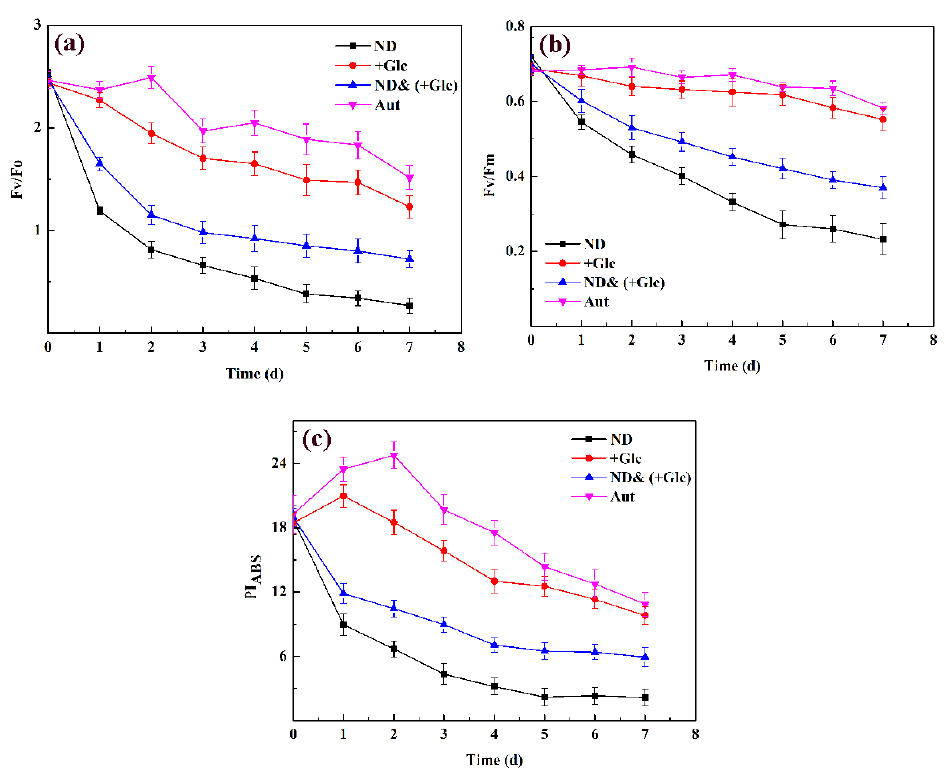
Figure 3. Changes in the chlorophyll fluorescence parameter in P. kessleri TY under different culture conditions: ( a ). Fv/Fo (the potential activity of photosystem II); ( b ). Fv/Fm (the maximum quantum yield of photosystem II photochemistry); ( c ). PI ABS (the maximum quantum yield of photosystem II photochemistry). Abbreviations: Aut. autotrophic; ND. nitrogen deficient; +Glc. mixotrophic (+Glucose); ND& (+Glc). nitrogen deficient & mixotrophic (+Glucose). (Mean ± SEM, n = 3).